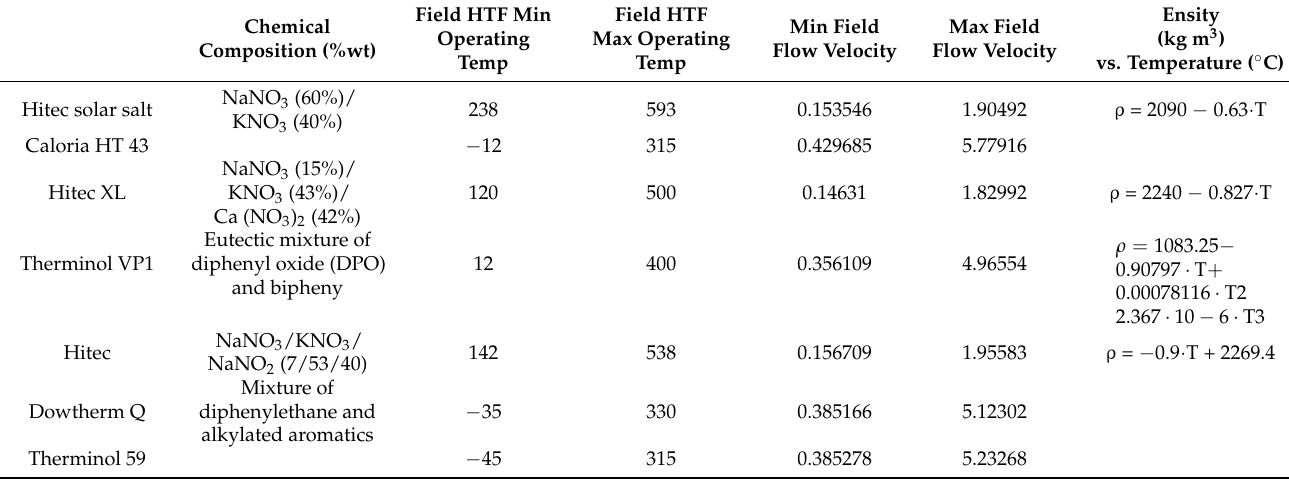
Table 3. Heat transfer fluid